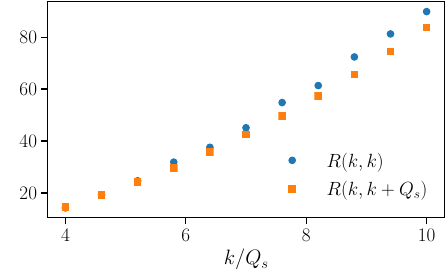
¯ k (cid:5) / (cid:4) v 2